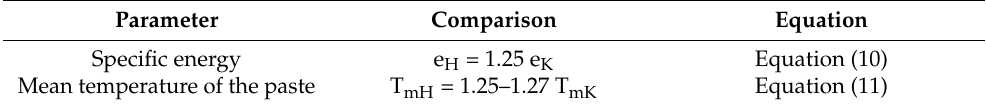
Table 3. Comparison of the main parameters derived from comminution